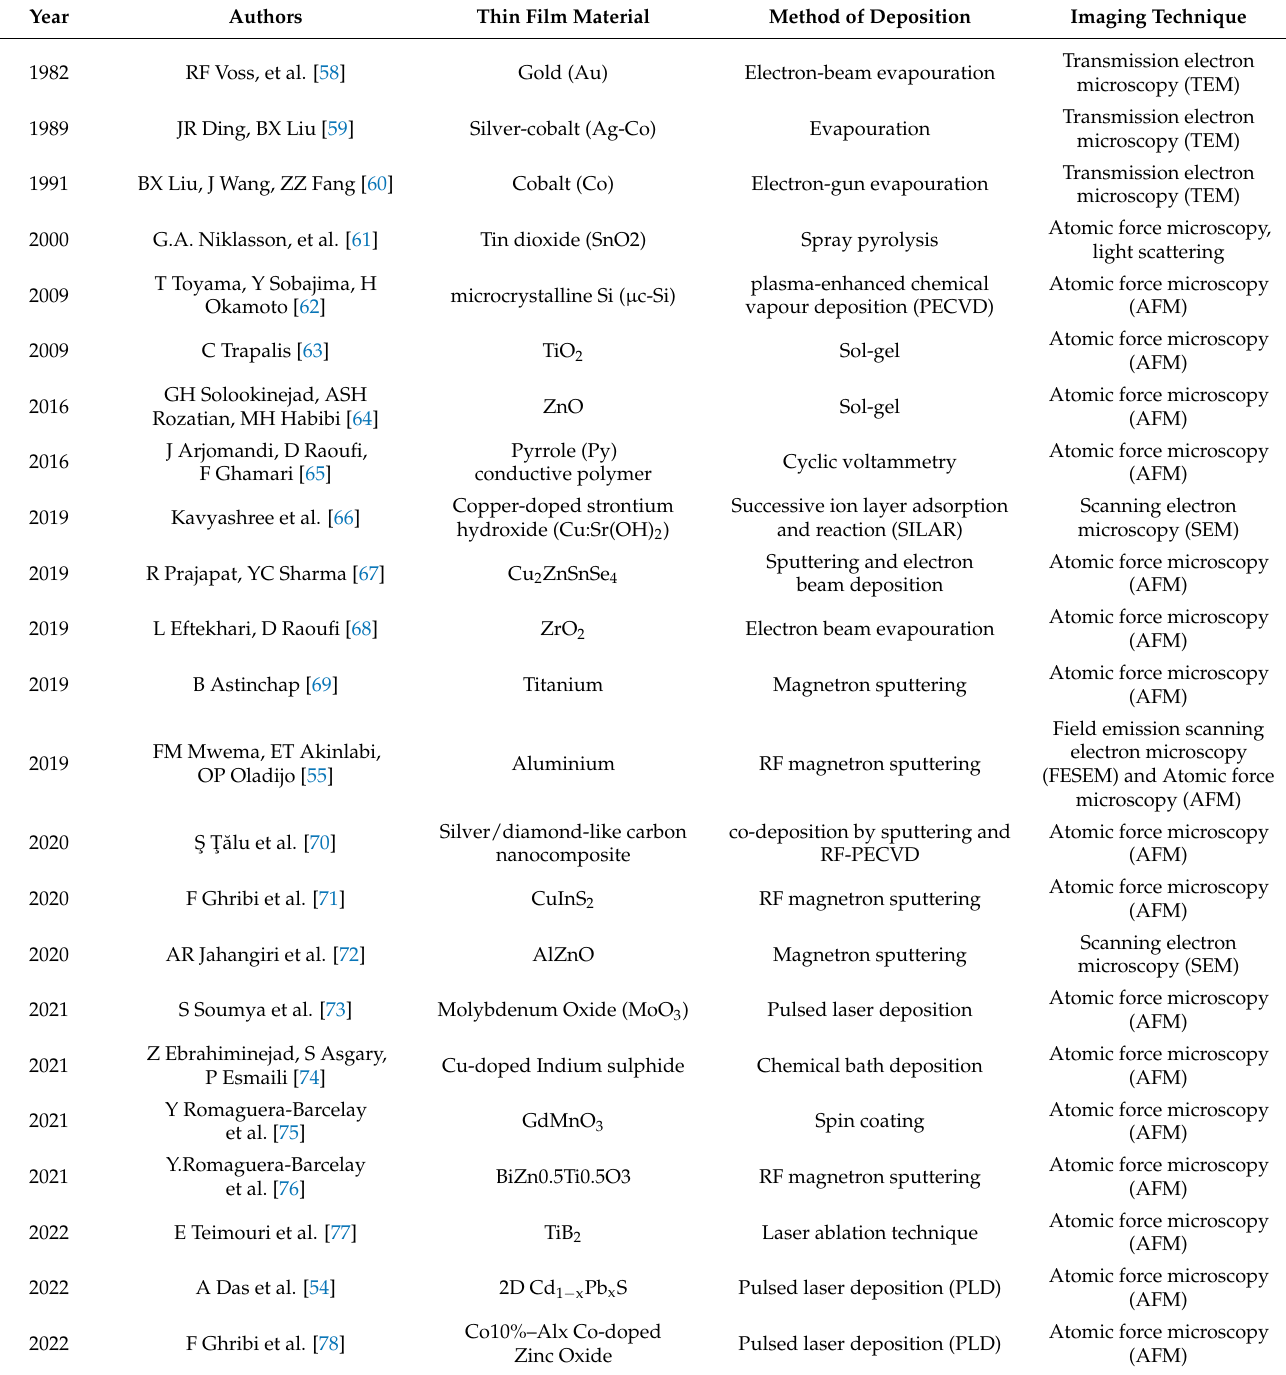
Table 6. Various thin film materials and their deposition methods characterized by fractal techniques